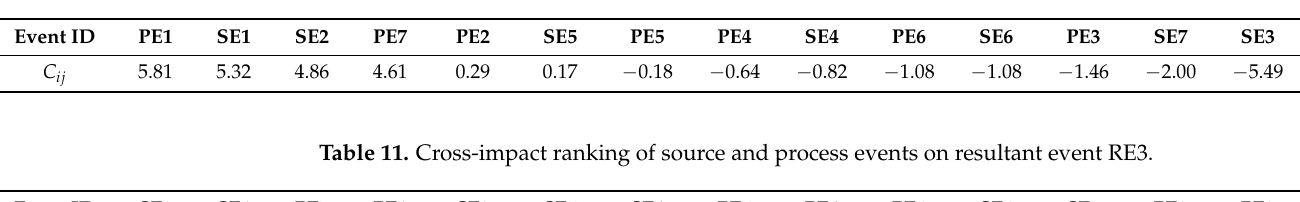
Table 10. Cross-impact ranking of source and process events on resultant event RE2.